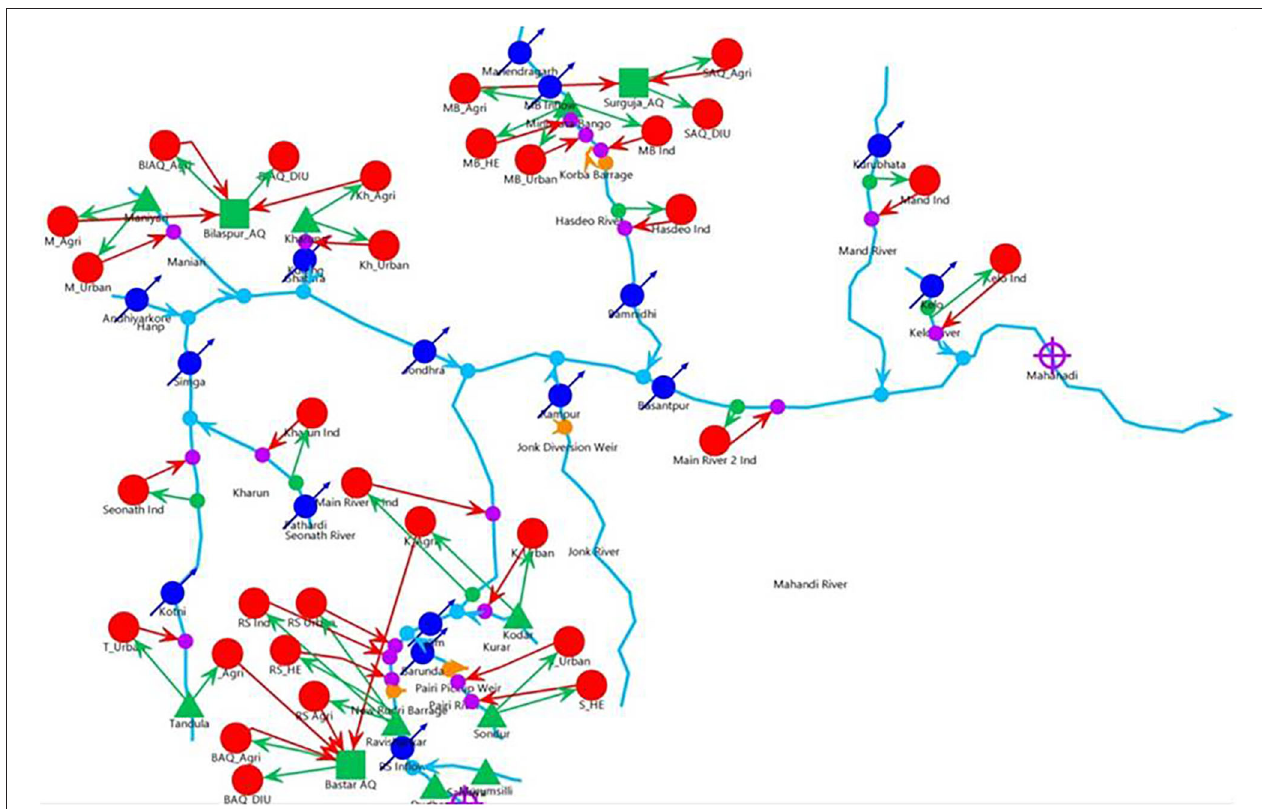
FIGURE 8 | The WEAP configuration for the study